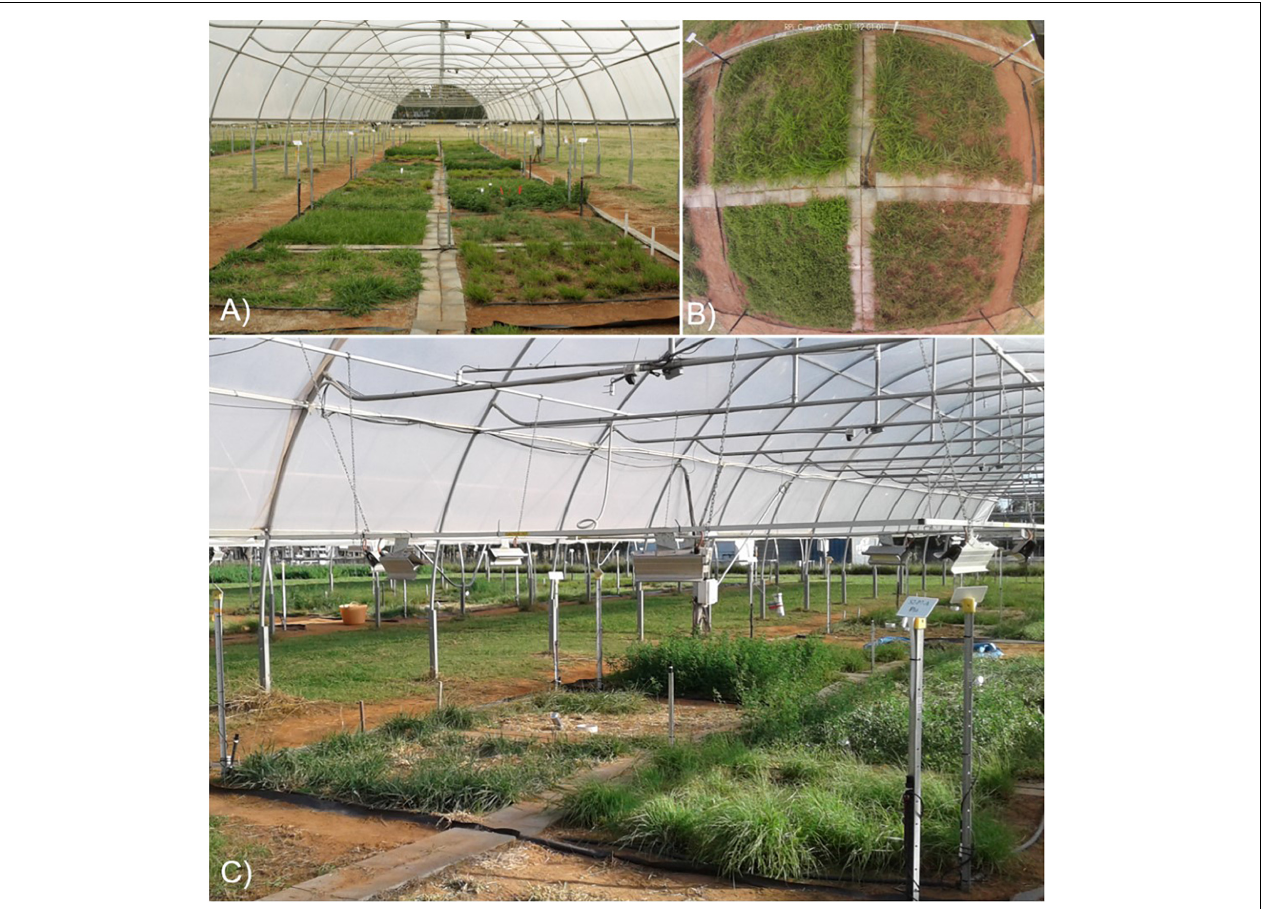
FIGURE 2 | The Pastures and Climate Extremes (PACE) field facility located at Western Sydney University in Richmond, New South Wales, Australia. (A) There are six open-sided polytunnels, each with eight experimental plots. (B) Experimental plots (4 m × 4 m) received a drought, warming, or drought + warming treatment and are each divided into four discrete 2 m × 2 m subplots comprising nine different pasture species in monoculture. (C) Heater (infra-red: IR) arrays were mounted above the vegetation canopy and warmed the plot surface an average of 3 ◦ C above paired (control, drought) ambient temperature